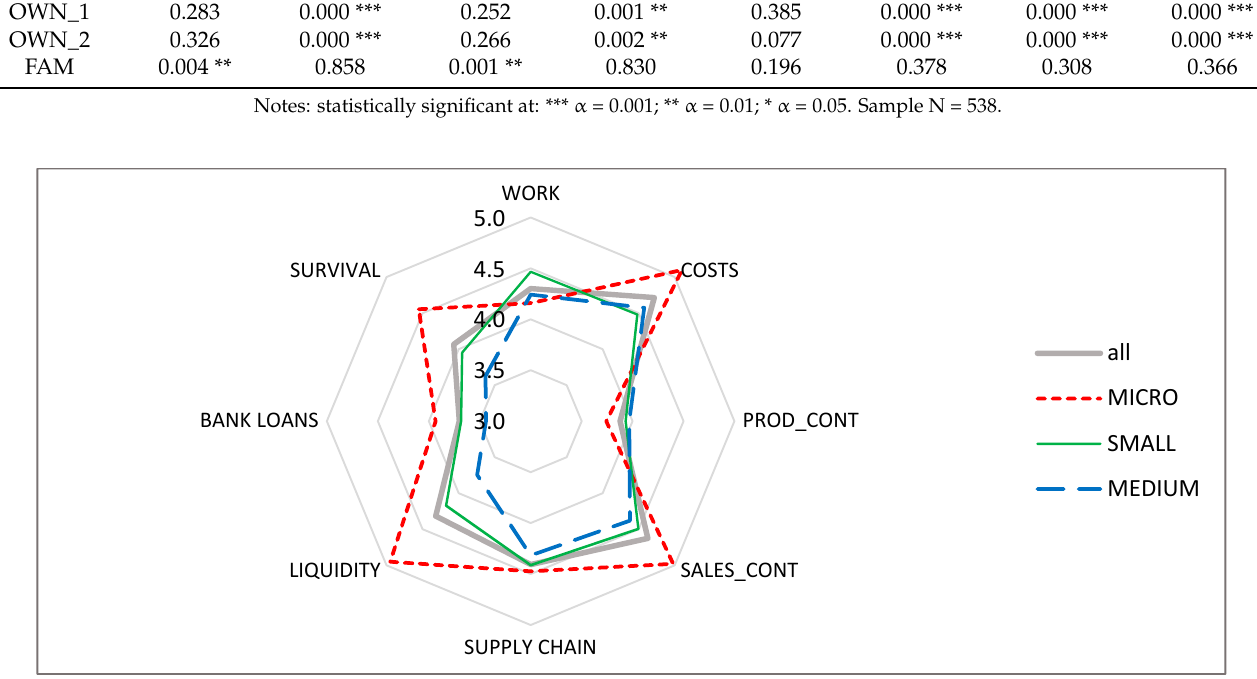
Figure 1. Perception of the COVID-19 interruptions and business size.